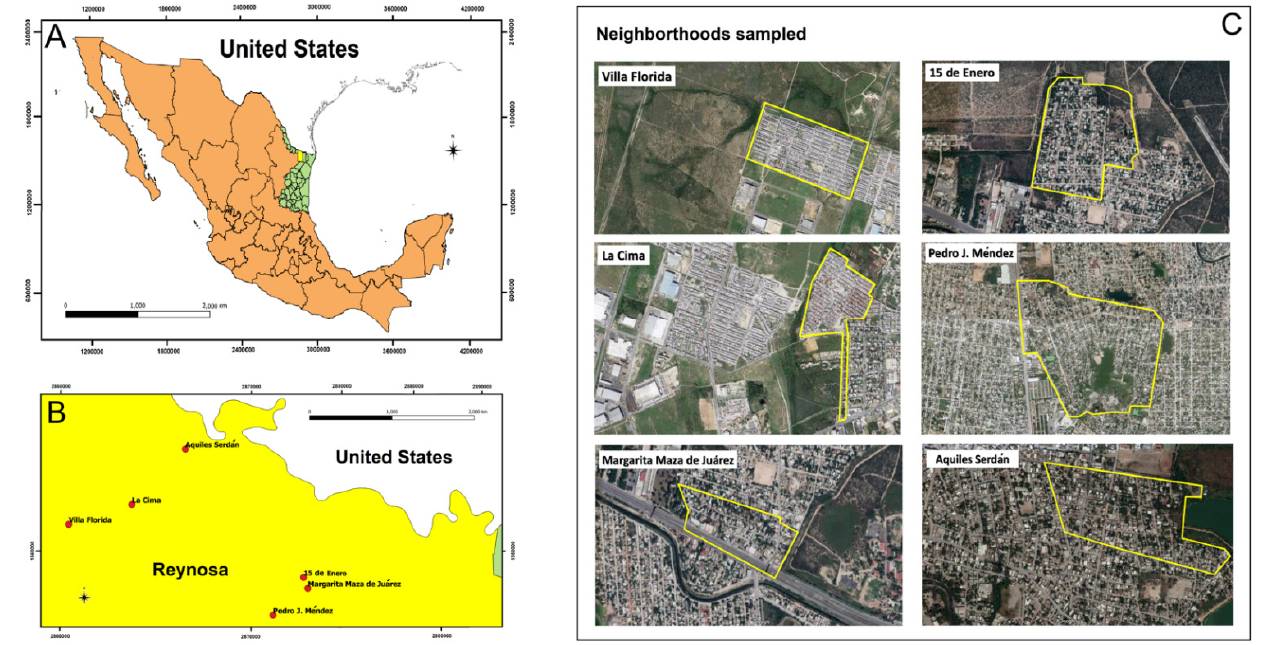
Figure 1. ( A ) Green area shows the State of Tamaulipas in northeastern México. ( B ) Red dots show the locations of the neighborhoods that were sampled within the city of Reynosa, in the State of Tamaulipas. ( C ) Satellite images show the land use composition of the six sampled neighborhoods in Reynosa. Figures are original maps, created by the authors using QGIS 3.18.2 with public domain map data from INEGI, and satellite images from Google maps. (https://qgis.org/en/site/) (accessed on 15 September 2021) with public domain map data from INEGI (https://www.inegi.org.mx/app/mapas/) (accessed on 15 September 2021), and satellite images from Google maps (https://www. google.com.mx/maps) (accessed on 15 September